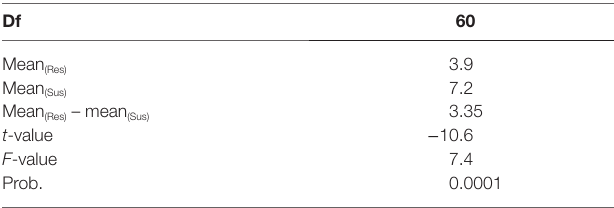
TABLE 9 | Summary of t -test of means and F -test statistics for the significance of the difference between variances of means for resistance to MLN between resistant and susceptible groups of BC 3 F 2